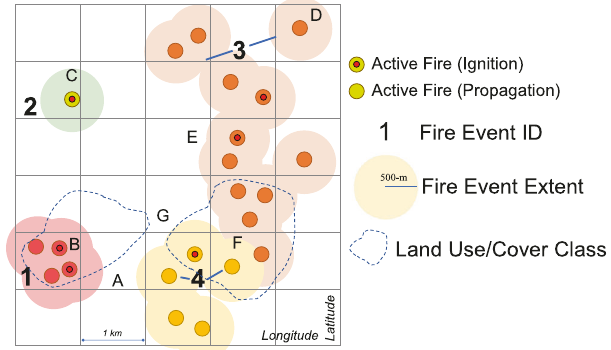
Fig. 4 Fire events as clusters of active- fi re detections. After Sloan et al. 17 . A Fire Events 1 and 4 are distinct, regardless of any similarity of their respective active- fi re detection (AFD) dates, because their AFDs are separated by at least one 1-km 2 grid cell. B Multiple AFDs of the same earliest date per fi re event are all considered ignition AFDs. C For fi re events de fi ned by a single AFD, the AFD is always an ignition AFD. D The 500-m buffer surrounding an AFD is relevant only for comparisons with burned area maps in Supplementary Note 4. E AFDs of adjacent cells must be detected within four days of each other to belong to the same fi re event, regardless of the total duration of the fi re event, which may be up to many weeks. F Spatially proximate AFDs belong to different fi re events when they are separated from each other by more than four days. G For analysis of fi re activity by land-management intensity (Table 2), the incidence of a land- use/cover class amongst a given set of fi re activity is given by the overlap of the class and eligible AFDs, not the whole fi re